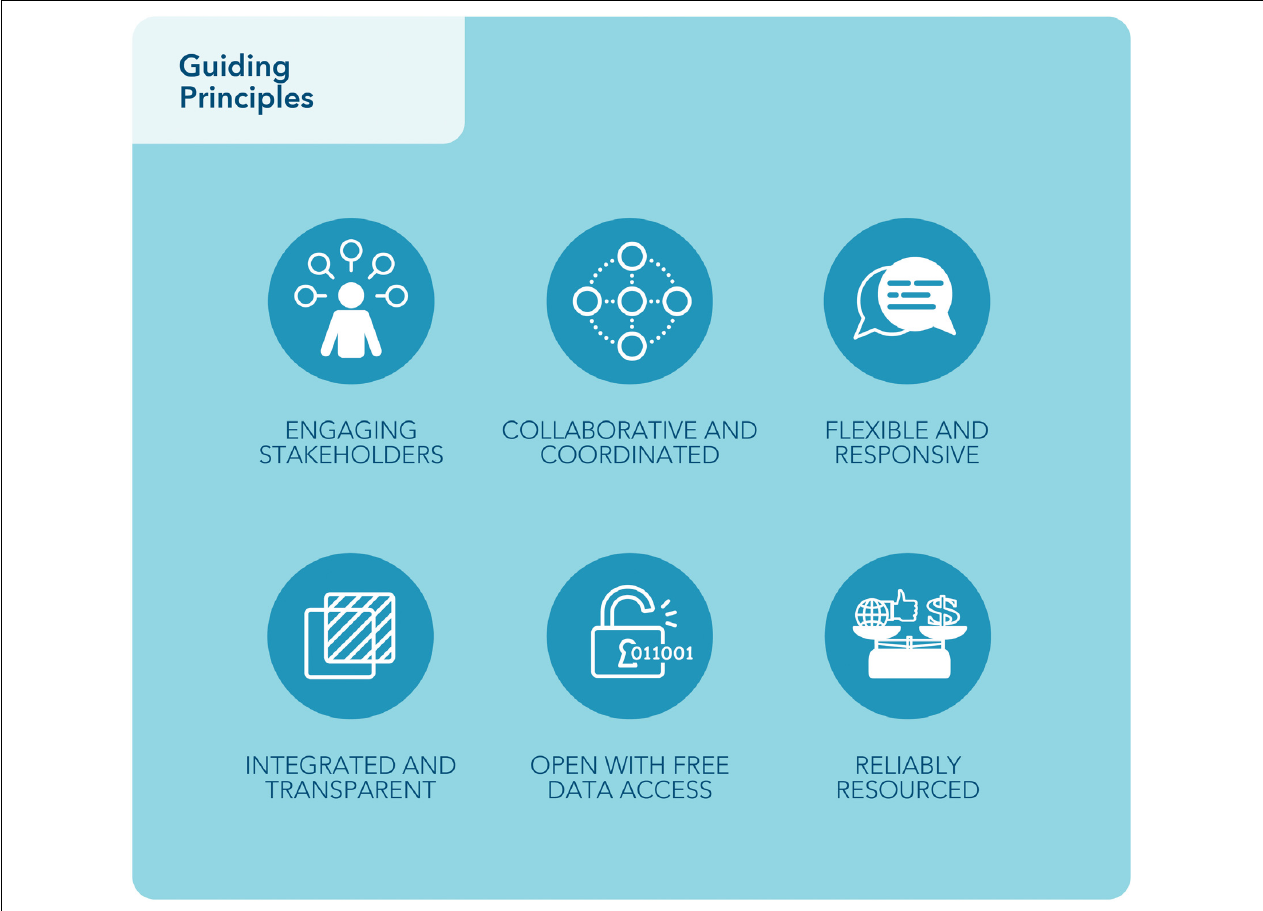
FIGURE 12 | Guiding principles. Six guiding principles of governance have been identified as necessary for creating a sustainable, effectively-governed